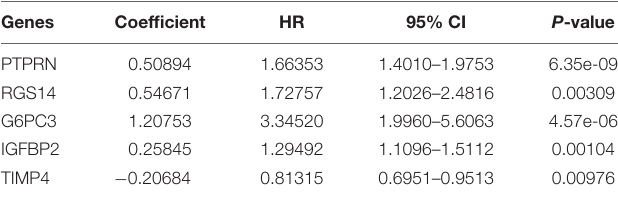
TABLE 1 | Information about the five genes screened to build the risk score